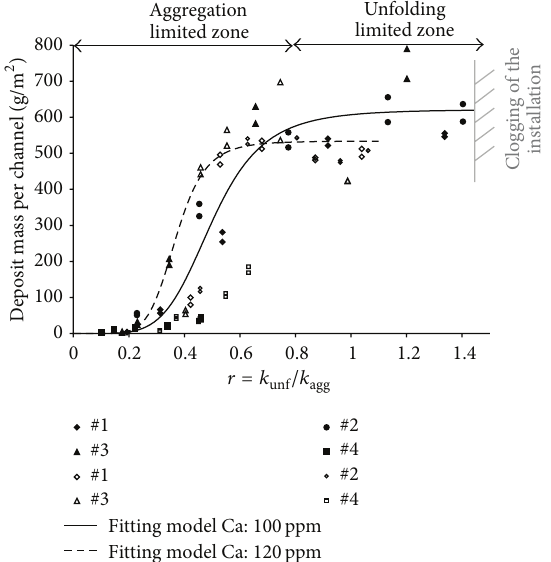
Figure 10: Plots of the dry deposit masses per unit area versus the ratio of unfolding and aggregation rate constants for the 1% w/w WPI solutions (closed symbols: 100ppm calcium; open symbols: 120 ppm calcium) (# 𝑖 corresponds to the thermal profile number given in Figure 4 and Table 2).